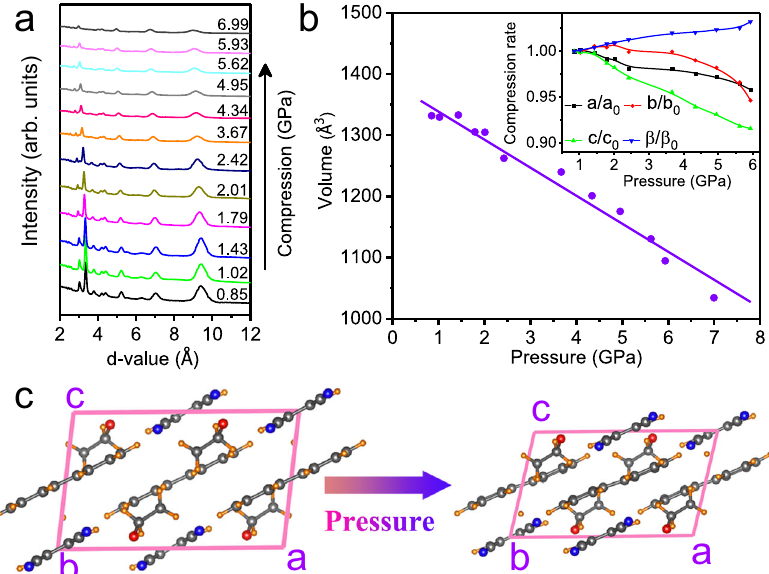
Fig. 3 High-pressure XRD patterns of PTCs – THF. a High-pressure XRD patterns of PTCs – THF up to 6.99 GPa. b The plotted curves for the unit cell volume of PTCs – THF as a function of pressure. The inset shows the compression rate of lattice constants as pressure increases. The XRD patterns are analyzed by JADE. c Evolution of the molecular arrangement with increasing pressure (view along the b